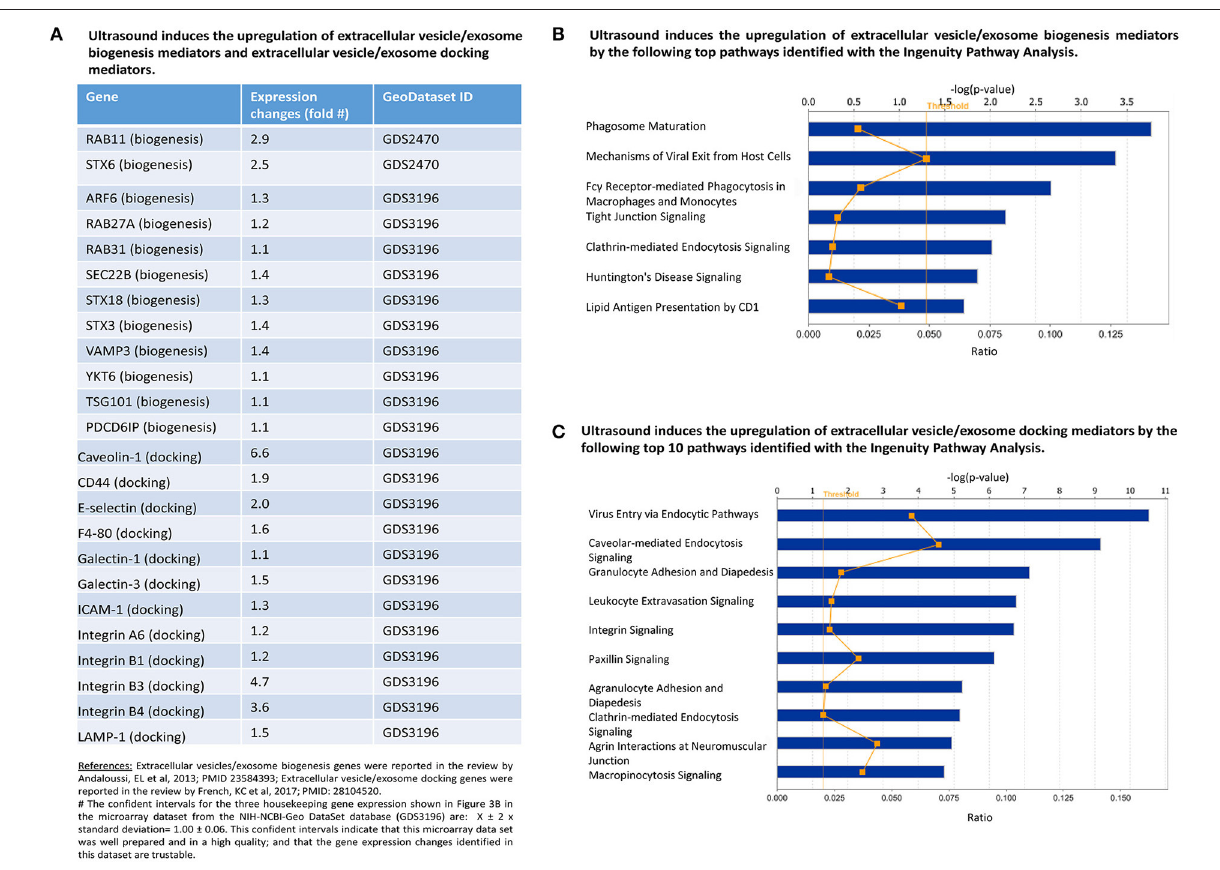
Frontiers in Physiology |